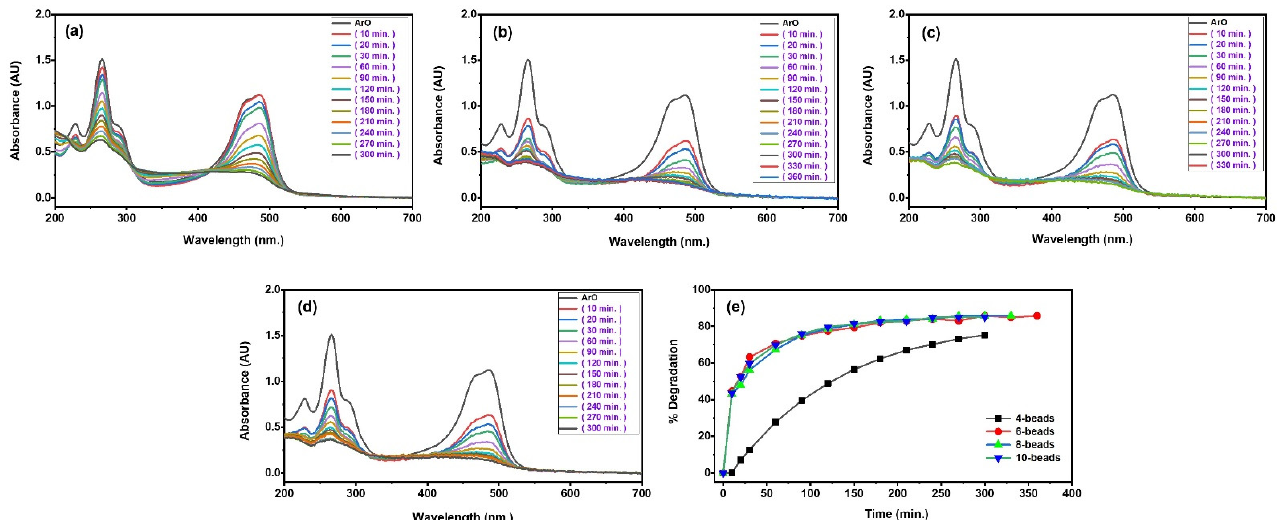
Figure 9. UV–vis absorption spectra for the photodegradation of ArO (0.07 mM) under solar light using ( a ) 4 beads, ( b ) 6 beads, ( c ) 8 beads, and ( d ) 10 beads of Cu@Alg/Co–CeO 2 catalyst. ( e ) % Degradation of ArO as a function of time.